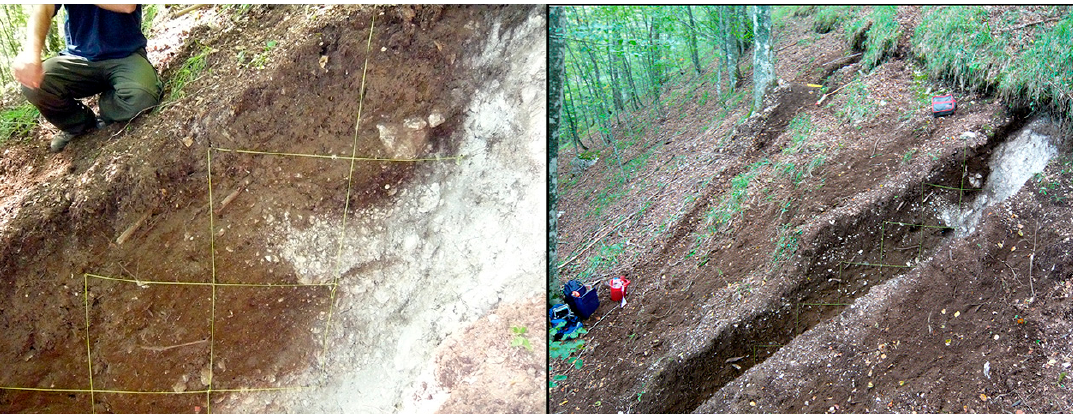
Figure 6. View of trenches T1–T2 during the excavation along the >30° dipping slope of Monte Valva-Marzano (summer 2010). Note, in the right panel, the 1980 surface offset, still visible after 30 years. The blow-up of T2 (left panel) focuses on the tectonic wedges formed in the 989 and 1694 surface faulting (see details in [7]) (photos by P.G.).